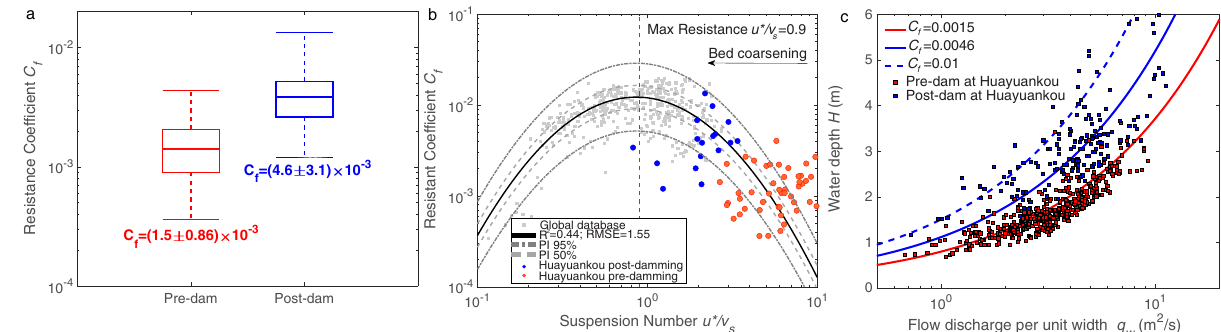
Fig. 4 Adjustment of fl ow resistance coef fi cient C f at the impacted reach of the Yellow River, before and after construction of the XLD dam, and its subsequent impact on fl ood-water depth. a The average value of C f in the post-damming bed roughness state is three times that for the typical pre-damming state at Huayuankou, the impacted reach of the Yellow River. Elements of the box-plot include: center line, mean value; box limits, upper and lower quartiles; whiskers, max and min values; b Relation between resistance coef fi cient and suspension number. The resistance coef fi cient at Huayuankou under pre- and post- damming conditions agrees well with the proposed hump-shaped relation, e.g., log 10 Y = − 1.75(log 10 X + 0.066) 2 − 1.91; c Comparison of H - q w relations at the impacted reach of the Yellow River before and after dam construction. The fi gure illustrates the theoretical relation H = ( C f / gS ) 1/3 q w 2/3 with C f values inferred in ( a ), and independent fi eld data collected at Huayuankou, for both pre- and post- dam conditions. The blue solid line, using averaged post-damming C f = 0.0046, shows H is 1.4times greater thanpre-damming; blue dashed line, using themaximum post-damming C f = 0.01, illustrates H is 2.0 times greater than pre-damming. Comparison of H - q w relations at the non-impacted reach of the Yellow River (Lijin) before and after dam construction is shown in Supplementary Fig. S4.